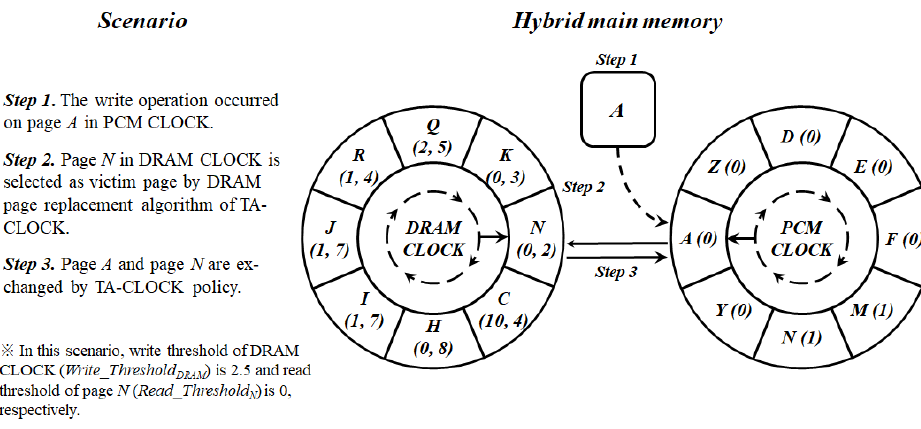
Figure 5. Example of page exchange in the DRAM CLOCK and the PCM